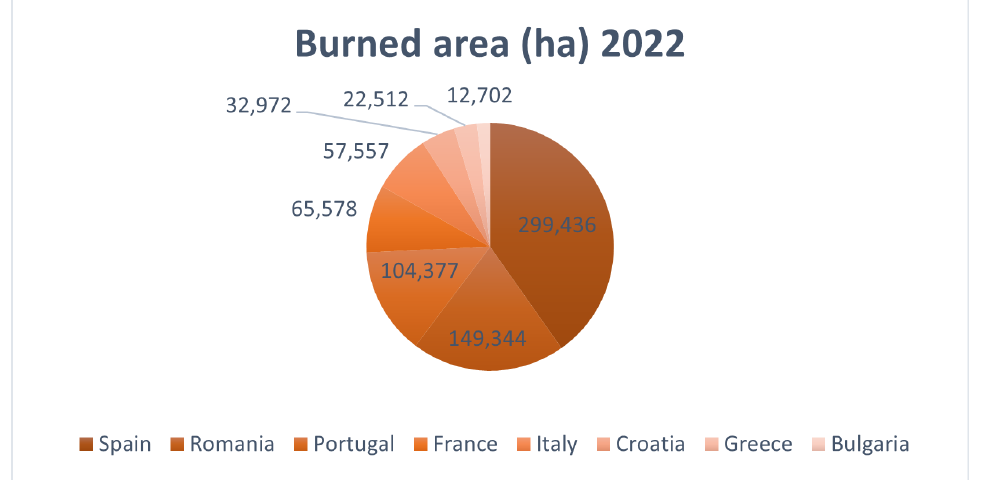
Figure 1. Burned hectares in the most-affected European countries (more than 10,000 ha) during 2022. Data from EFFIS on 28 September